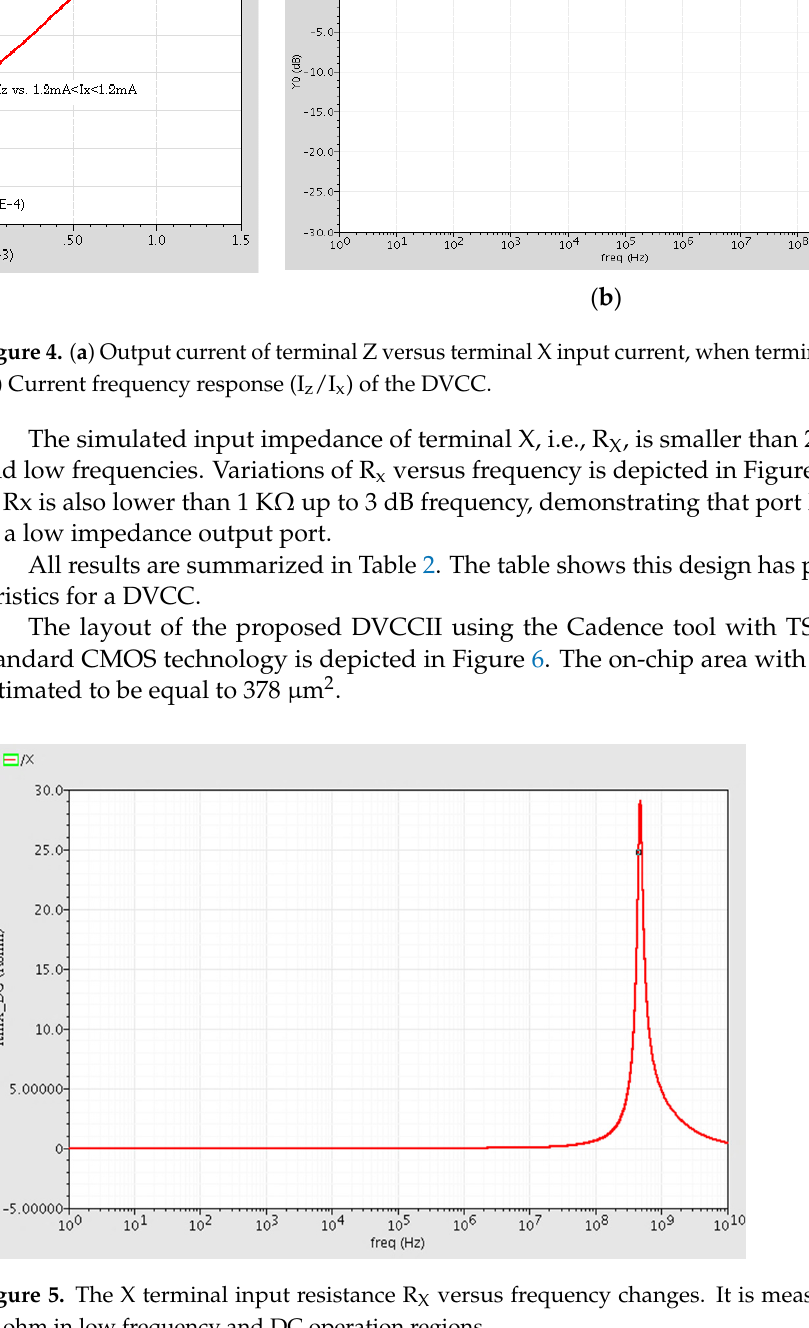
Table 2. Simulation results of designed DVCCII.